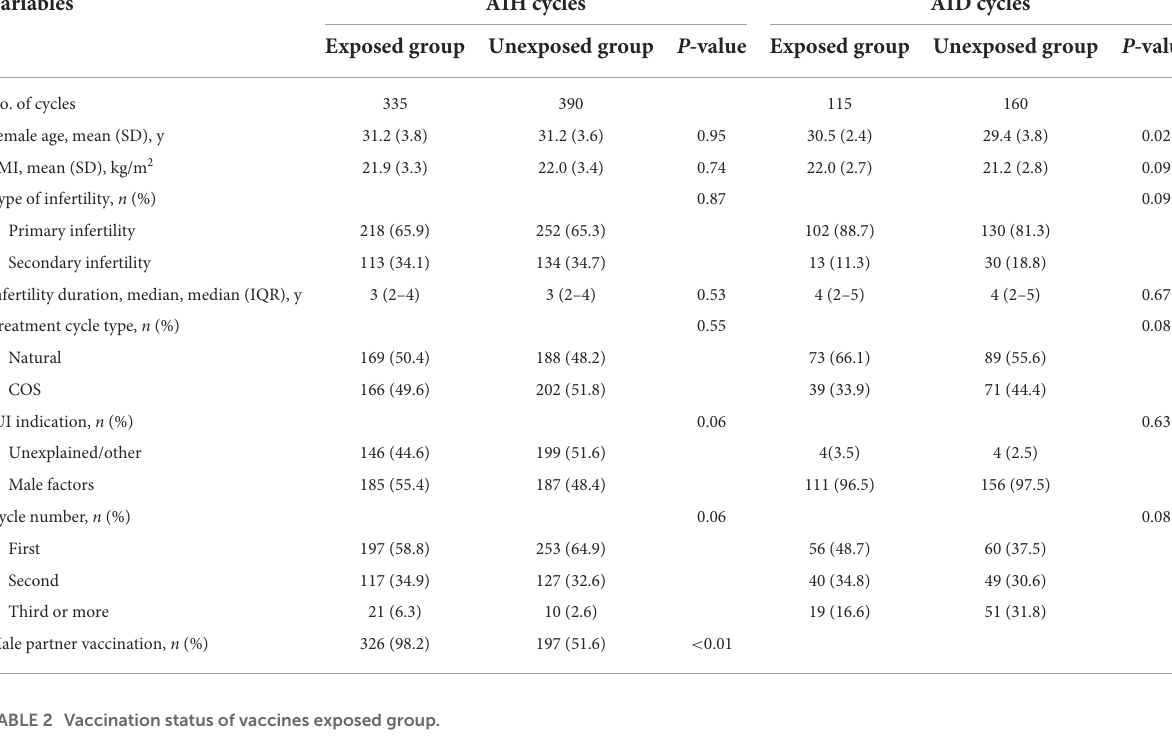
TABLE 1 Baseline characteristics per artificial insemination cycles with husband or donor semen stratified by vaccination exposed or not.